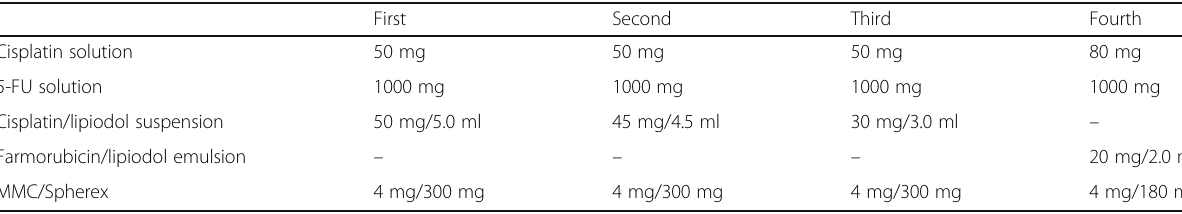
5-FU 5-fluorouracil, MMC mytomycin